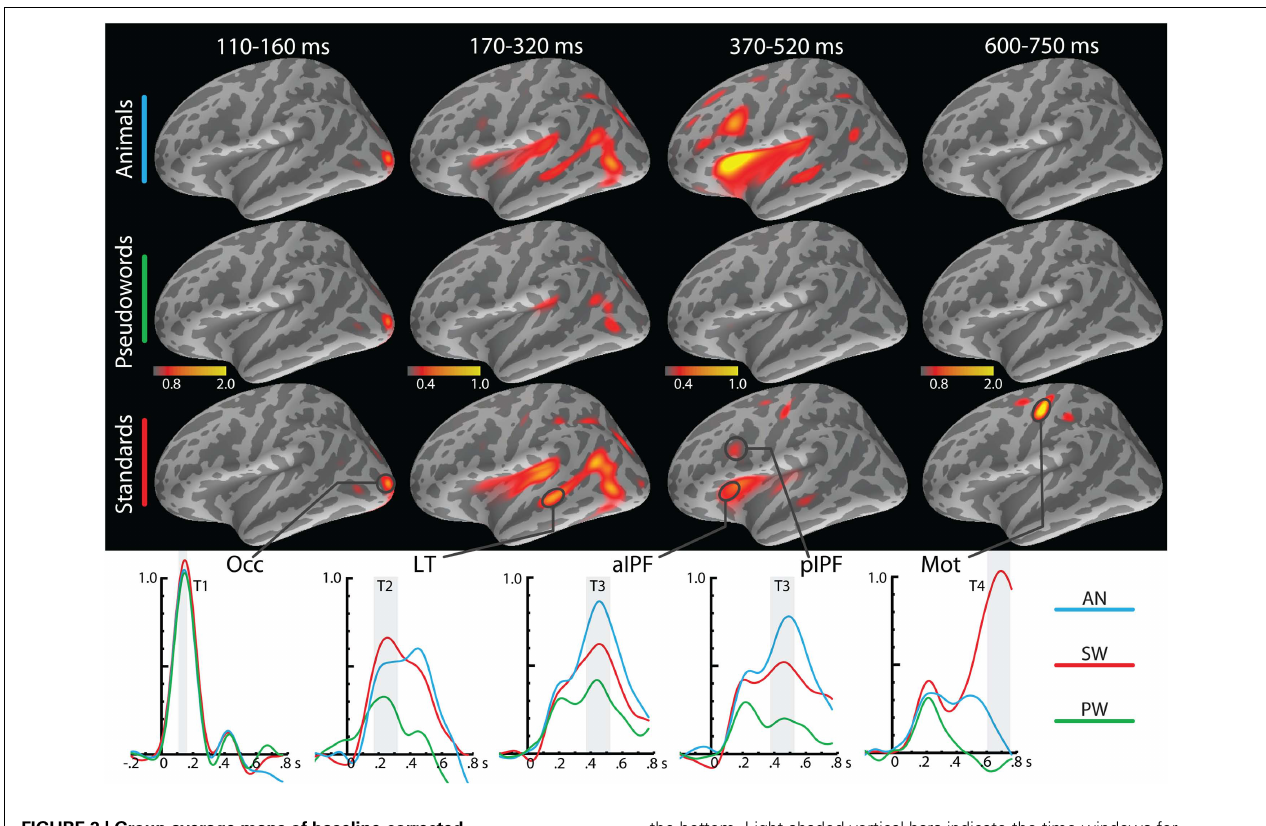
FIGURE 2 | Group averagemaps of baseline-corrected event-related theta source power estimates in the left hemisphere for the three conditions under placebo at different time points. The earliest activity is estimated to the occipital cortex, followed by the left lateral temporal and inferior prefrontal estimates during the processing of lexical-semantic characteristics and decision conflict. During response preparation and execution stage, theta power is estimated to the hand-centered motor area. Group average timecourses of theta source power estimates in selected regions of interest are shown on